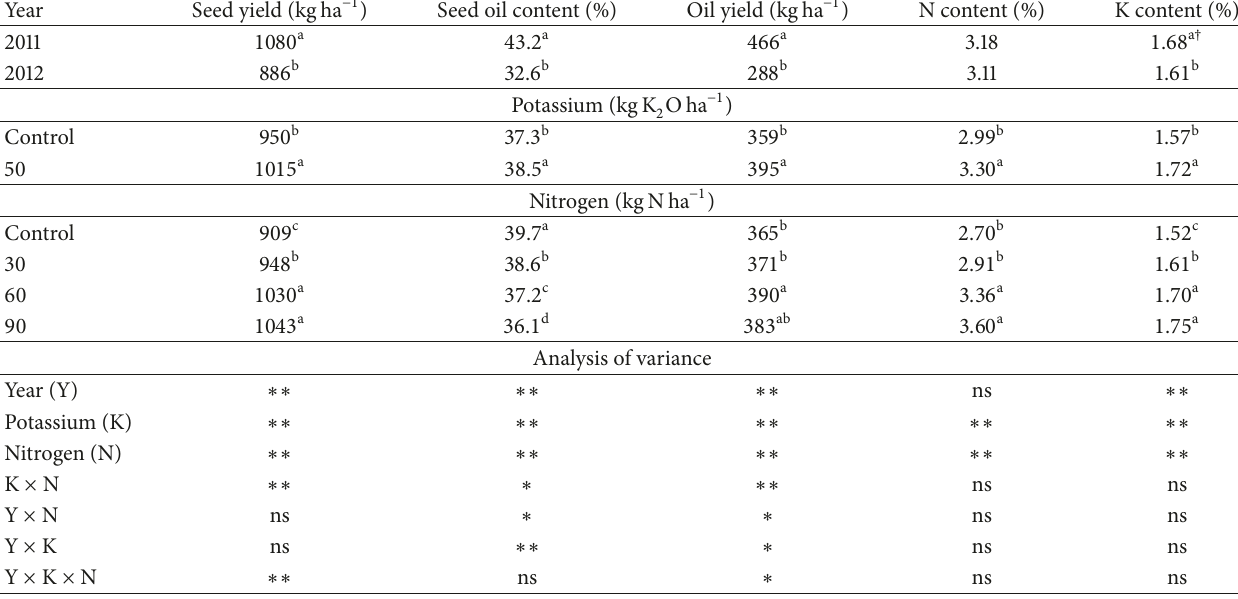
Table 2: Main effects of N doses and supplemental K on seed yield, seed oil content, oil yield, and N and K contents in seeds of black cumin. Year